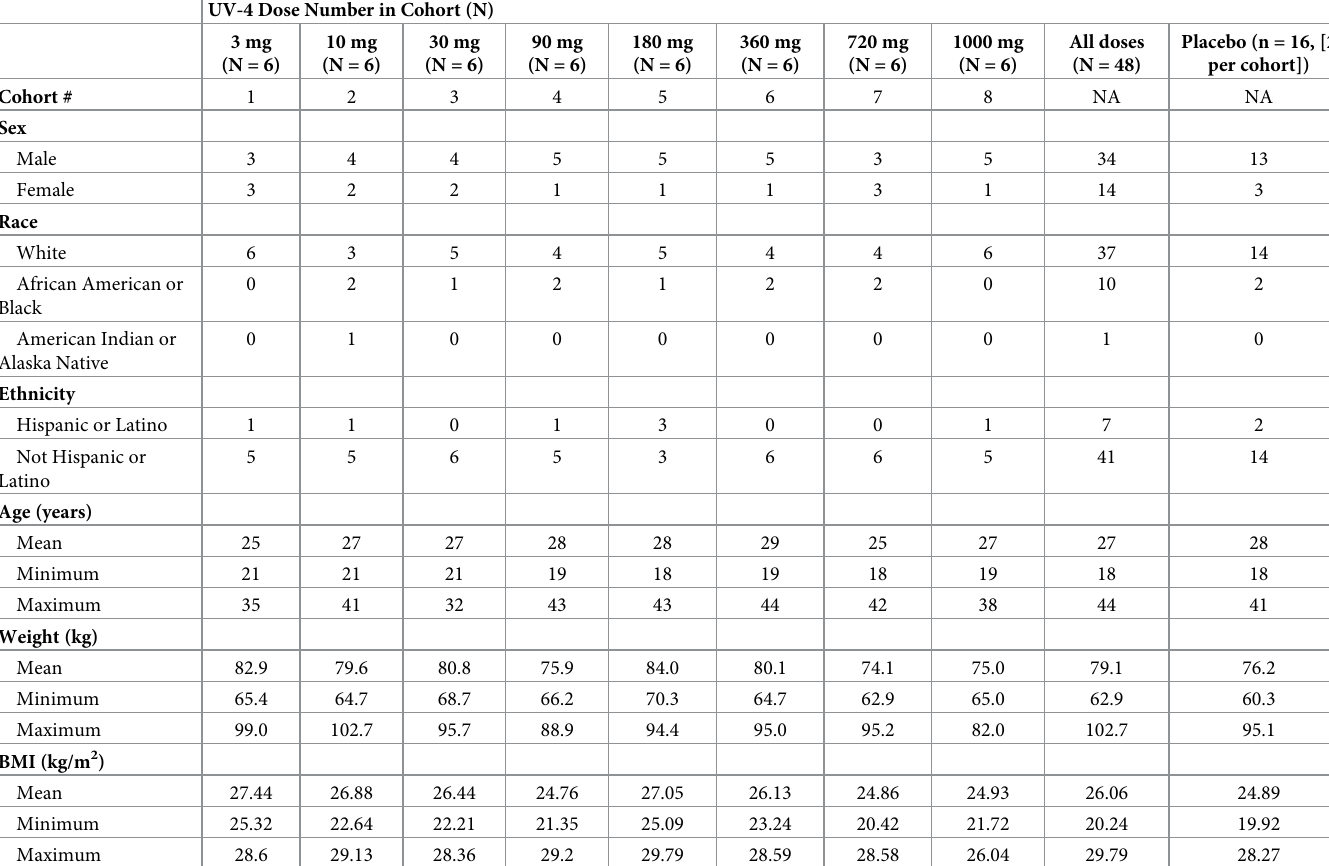
Table 1. Demographics and Baseline